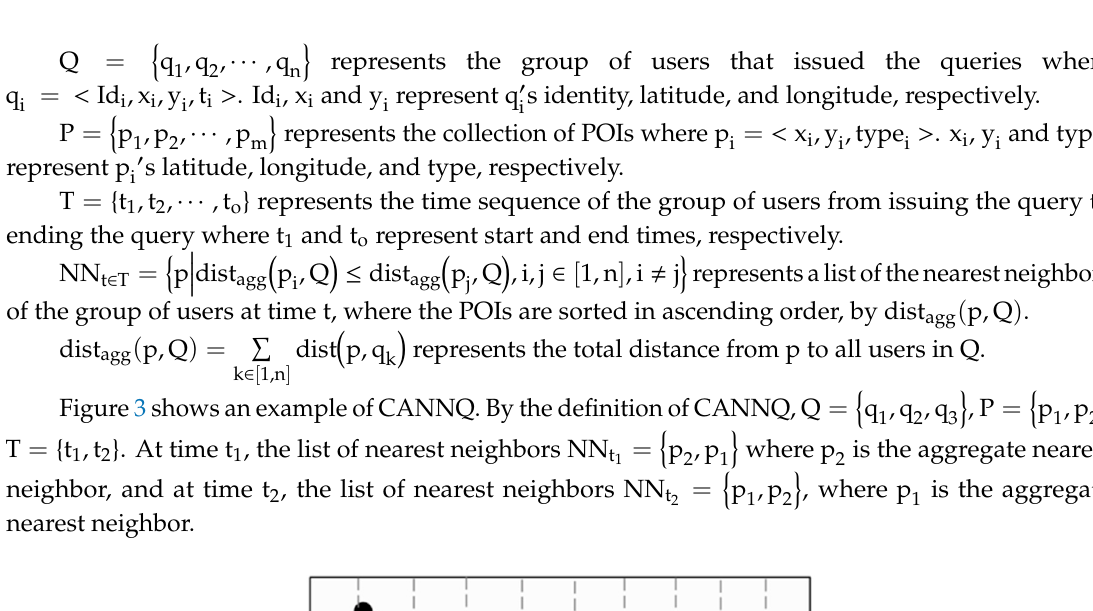
Table 1. Summary of